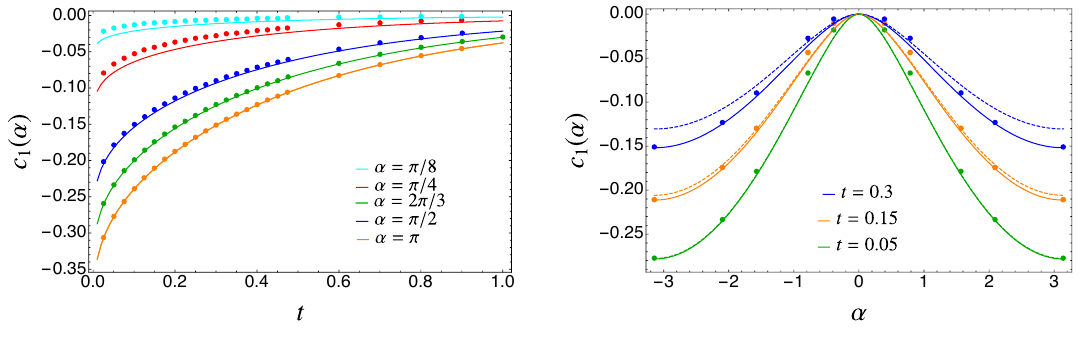
Figure 8 . Left panel: logarithmic derivative of the charged moments, c 1 ( (cid:11) ), as a function of t = m‘ obtained by solving numerically the Painl(cid:19)eve equation (5.6) (solid lines). The data (symbols) are obtained (cid:12)xing (from top to bottom) ‘ = 720 ; 620 ; 420 ; 420 ; 320 and varying properly m in such a way that m‘ 2 (0 ; 1). As discussed in the main text, the agreement with the numerical data worsens as (cid:11) decreases. Right panel: the same quantity is plotted as a function of (cid:11) from the numerical solution of the Painlev(cid:19)e equation (solid lines), showing also in this case that the agreement as (cid:11) ! 0 is not excellent. The dashed lines represent the small t expansion in eq. (5.10): the smaller is t , the better the approximation